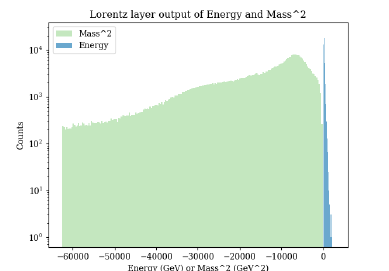
Figure 4. Output of the Lorentz layer calcula- tions after standardization. The invariant mass and energy distributions are now on compara- ble scales.